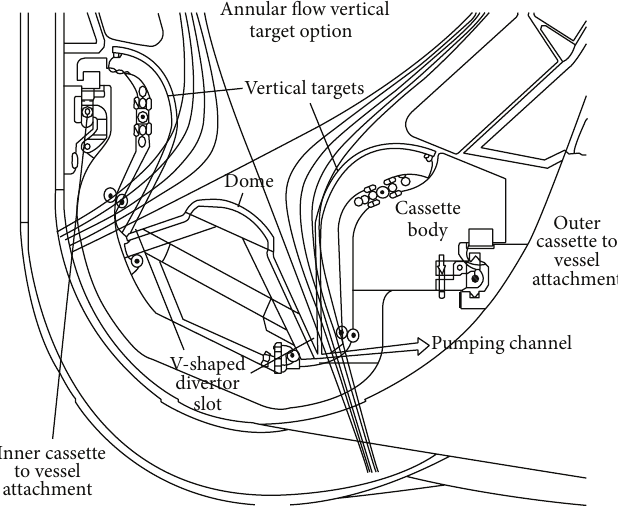
Figure 3: Cross section through the divertor. This shows the V-shaped strike zones and the pumping path as well as the attachment to the toroidal rails [43].